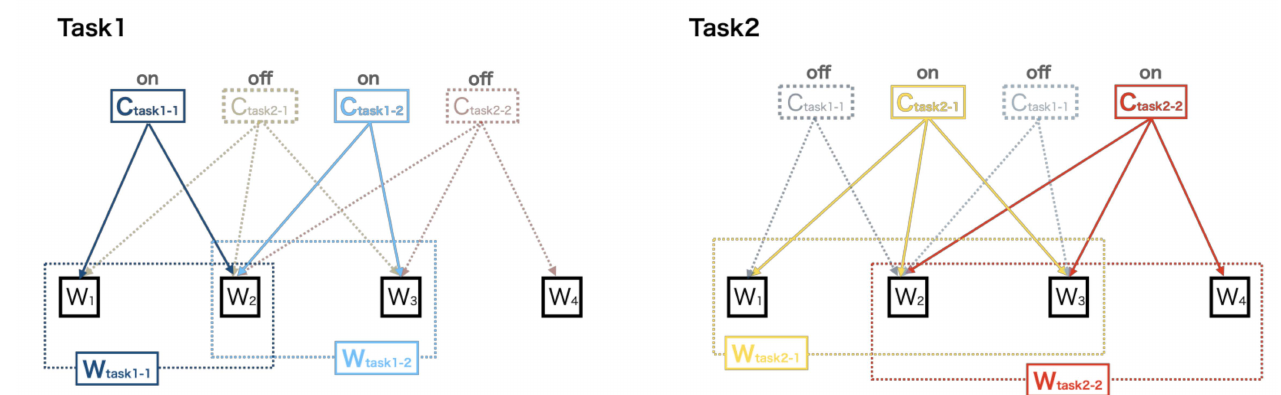
Figure 4. A hypothetical neural mechanism of merged fundamental muscle synergies with its temporal patterns in a diverse range of human behaviors. This model shows that the CNS flexibly recruits multiple synergies for different tasks. For example, C task1-1 with W 1 and W 2 and C task1-2 with W 2 and W 3 turn on while C task2-1 and C task2-2 turn off to execute task 1. Similarly, C task2-1 with W 1 , W 2 , and W 3 and C task2-2 with W 2, W 3 , and W 4 turn on, ceasing to be active in C task1-1 and C task1-2 for task